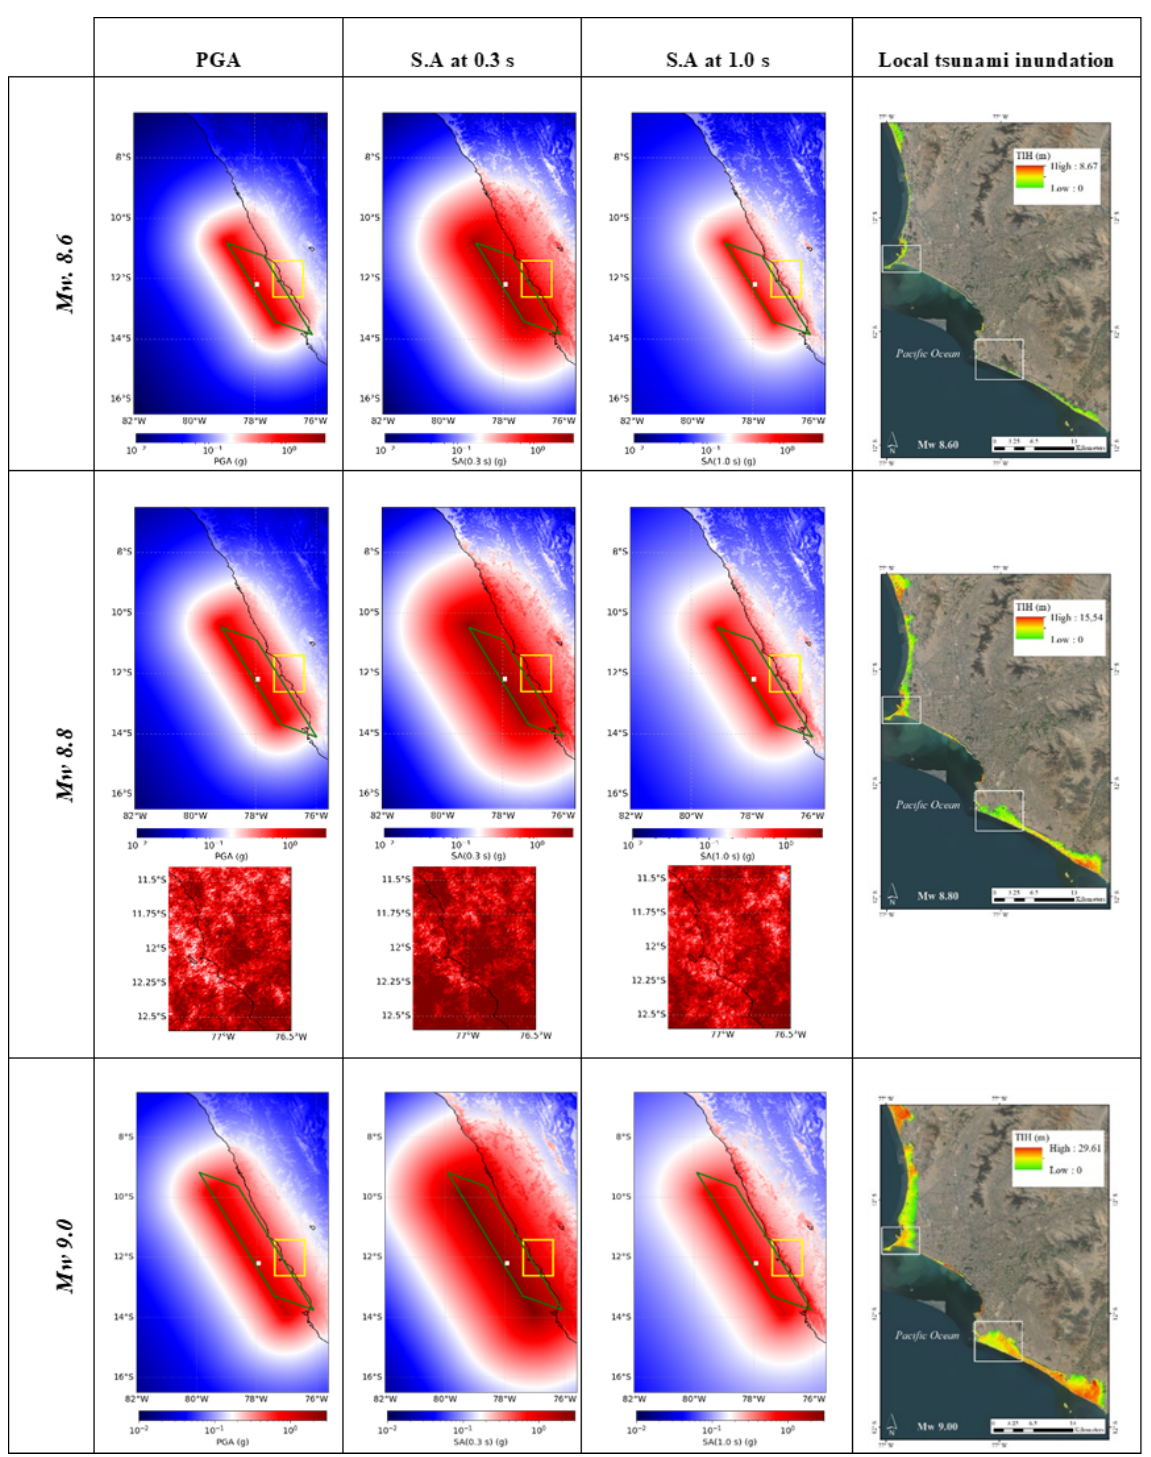
Figure 1. Median seismic ground motion for a single realisation using the Montalva et al. (2017) GMPE for peak ground acceleration (PGA) and spectral acceleration (SA) for periods of 0.3 and 1.0s and for three scenarios ( M w 8.6, 8.8, and 9.0) along the Peruvian subduction zone. Green rectangles represent the rupture planes. Hypocentres are shown by white dots. The study area (metropolitan Lima) is enclosed within a yellow rectangle. For this area, and for the M w 8.8 scenario, one realisation of spatially cross-correlated ground motion field per spectral acceleration is shown. Tsunami inundation heights for the three selected scenarios are displayed for the study area. The northern “La Punta” sector (Callao district) and the southern Chorrillos district are indicated by white rectangles. Map data: © Google Earth